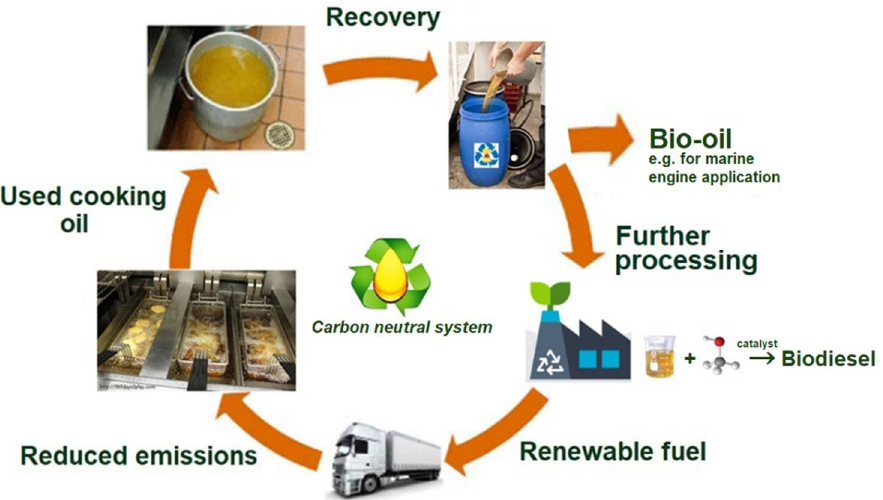
Figure 1. Schematic diagram showing the role of used cooking vegetable oils (UCOs) enabling a carbon neutral energy system. carbon neutral energy